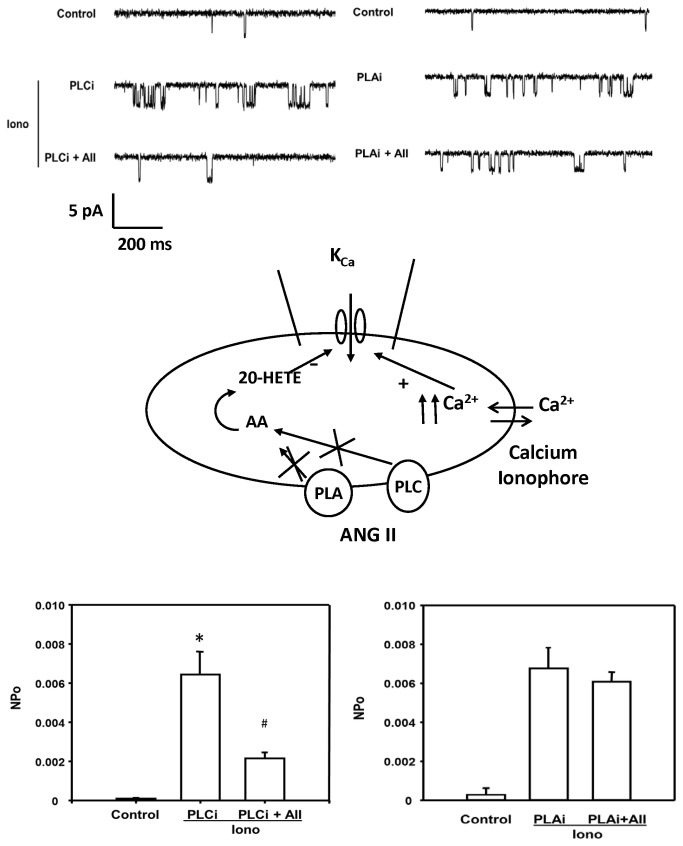
Effect of blockade of PLC and PLA2 on the inhibitory action of ANG II on KCa channel activity in renal VSM cells.The upper panel presents representative tracings of single KCa channel currents recorded at the resting membrane potential (pipette potential = 0 mV) in the cell-attached mode before and after addition of PLC inhibitor U-73122 (10-5 M) and U-73122 plus ANG II (10-7 M) to the bath (left). The effects of the PLA2 inhibitor, AACOF3 (2 x 10-5 M) and AACOF3 plus ANGII (10-7 M) are presented in the right panel. KCa channel currents were recorded with 140 mM KCl in the pipette at the resting membrane potential (pipette potential = 0 mV) and the cells were bathed in normal physiological salt solution in the presence of ionomycin. The middle panel summarizes the patch clamp recording mode. KCa channel currents were recorded as described in Figure 8. The lower left panel summarizes the effect of U-73122 and ANG II on the open probability of the KCa channel in renal VSM cells while the lower right panel depicts the effects of AACOF3 on the response to ANGII. * indicates a significant difference versus control and # indicates a significant difference from the corresponding value recorded after PLC activity was inhibited with U-73122 or PLA2 activity was inhibited with AACOF3.